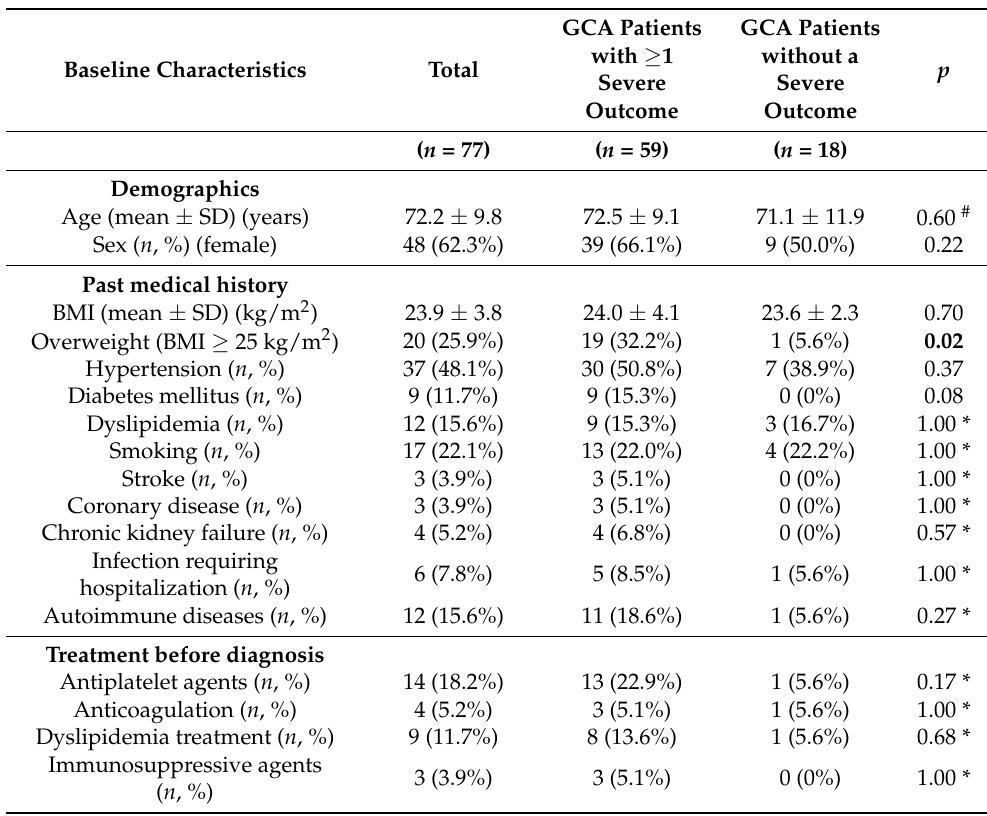
Figure 1. Flow chart of the selection of patients with giant cell arteritis followed at the Nimes University hospital. Table 1. Baseline characteristics and treatment strategy in 77 patients with giant cell arteritis according to the severe outcome onset.